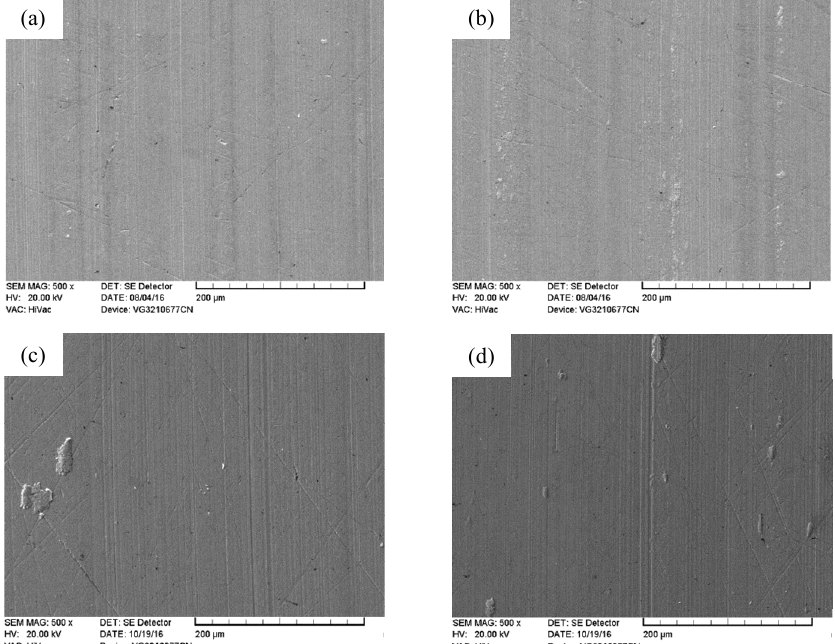
Fig. 14 Wear surface topography with the S07steel disk: PV = (a) 15 MPa·(m/s), (b) 20 MPa·(m/s), (c) 25 MPa·(m/s), and (d) 30 MPa·(m/s).